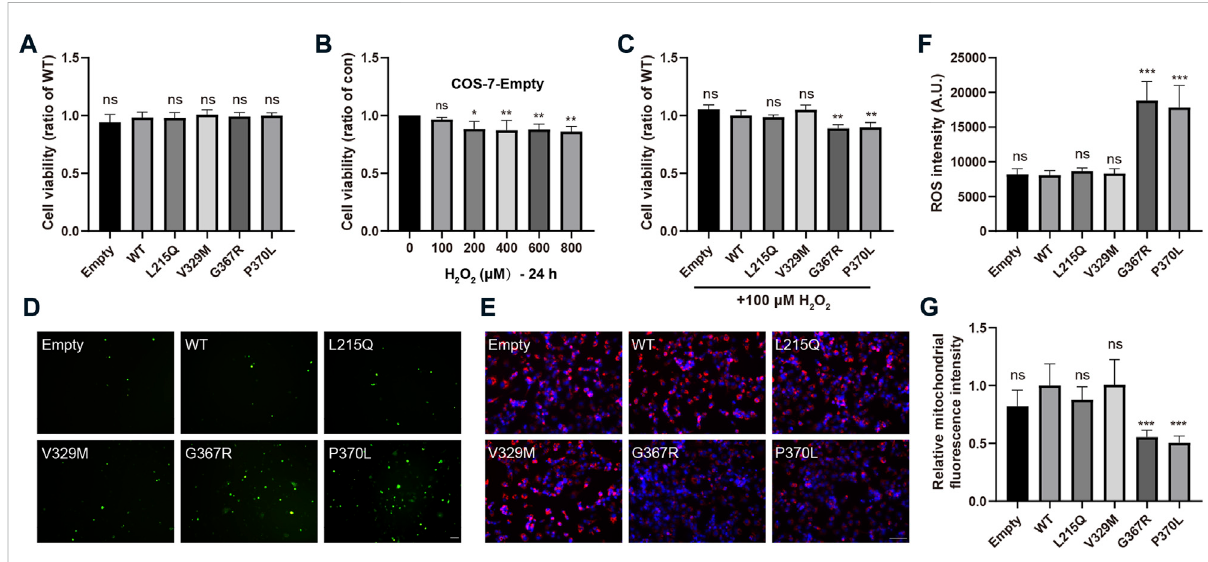
FIGURE 5 MYOC mutations induce cellular oxidative injury. (A – C) COS-7 cell viability was measured by MTT assays. (A) Expression of WT- or mut- myocilin had no effect on the viability of COS-7 cells. (B) Twenty-four hours of incubation with H 2 O 2 at 100 μ M did not inhibit the growth of COS-7 cells transduced with empty vector. (C) COS-7 cells transfected with different vectors were exposed to 100 μ M H 2 O 2 for 24 h. MYOC mutations increased the toxicity of H 2 O 2 to COS-7 cells. (D,F) Increased ROS generation measured by DCFH-DA staining in COS-7 cells